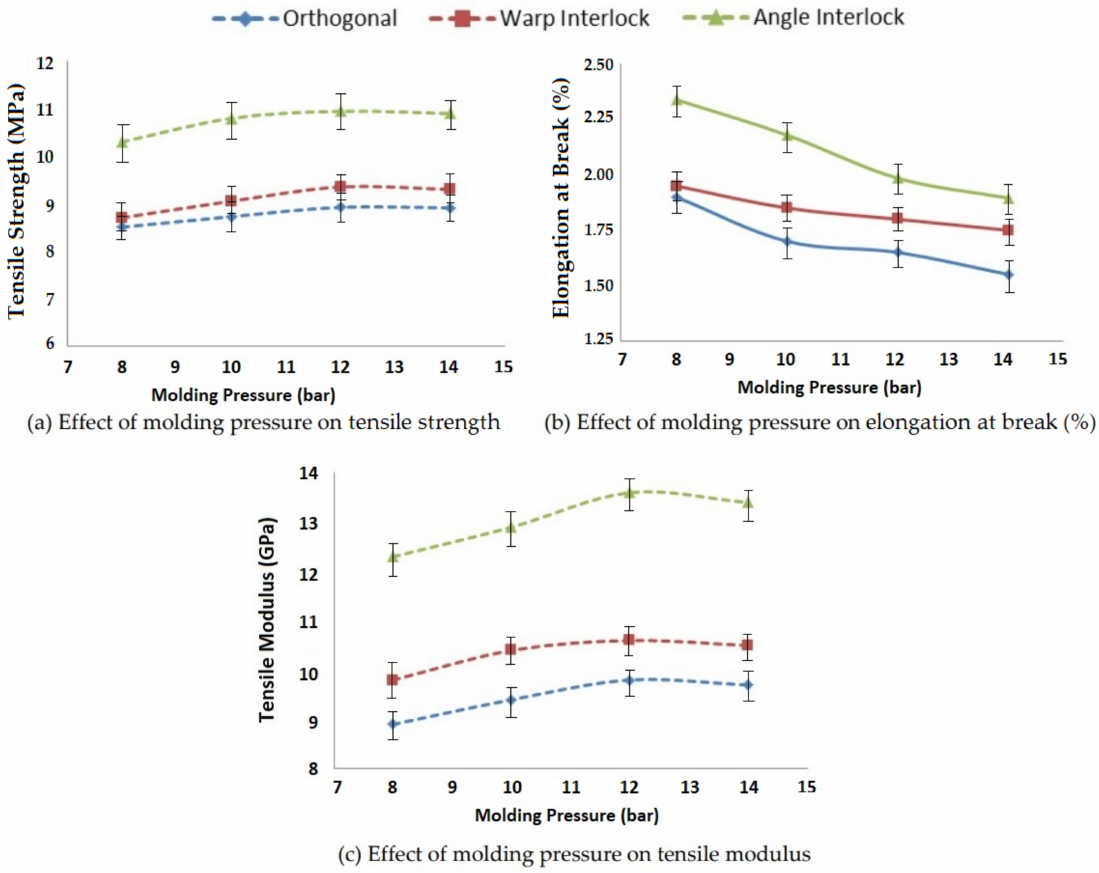
Figure 9. Effect of molding pressure on the tensile properties of 3D woven composites.